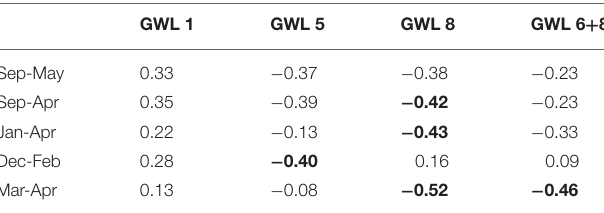
TABLE 2 | Correlation coefficients (r) between δ 18 O TRC and selected main weather types (Grosswetterlagen,